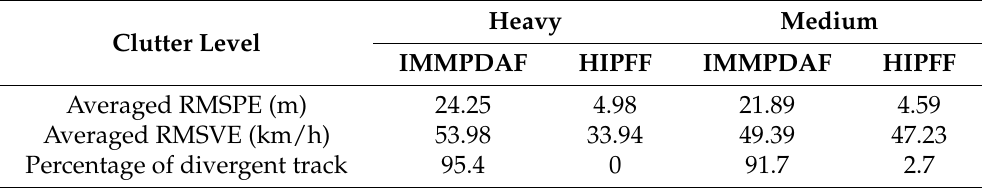
Table 2. MC simulation results under condition of v x ,0 = 100 km/h, d x ,0 = 120 m. Clutter Level